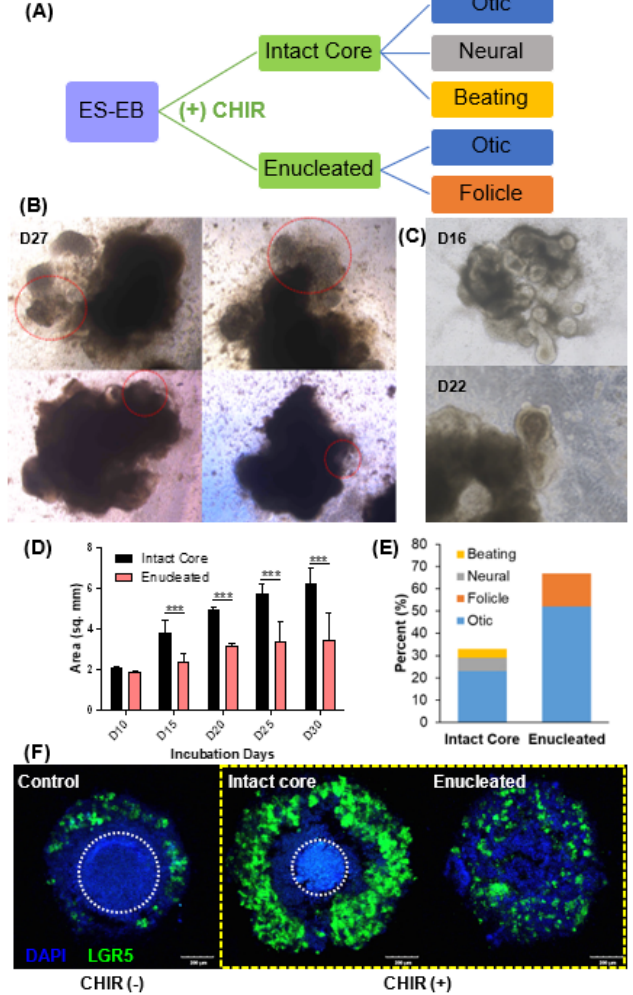
Figure 6. Evidence of differentiation into other lineages after application of a Wnt agonist (CHIR) (observation of ‘beating’ organoid). ( A ) Illustration of the different lineages arising from the core retention or enucleation. CHIR-treated EBs showed atypical morphologies, as shown in ( B , C ). On differentiation day 27 (D27) in CHIR-treated EBs, structures with round morphologies (red dotted line) were observed in both EBs with intact cores, as well as enucleated EBs. These structures showed spontaneous movements (‘beating’-like movements; Supplementary Video S1) suggesting alternative lineage differentiation ( B ). In addition, enucleated EBs ( C ) also generated hair follicle-like structures on differentiation day 16 (D16) and day 22 (D22). A comparison of the sizes between intact and enucleated EBs showed statistically significant differences starting at day 15 ( D ). All the organoid-bearing EBs after (+) CHIR treatment were classified according to the kind of organoids they developed ( E ). We conducted epifluorescence analysis of LGR5 expression in EBs at D11 after the treatment of CHIR99021 ( F ). The Wnt pathway target LGR5 was expressed in the control group without the addition of CHIR. There was an increase in LGR5 expression after CHIR treatment (yellow dotted rectangle) in EBs with intact cores, as well as in enucleated EBs. Encircled area by white dotted circle indicates the core of control and intact EBs. Scale bar indicates 200 µ m. (*** p <